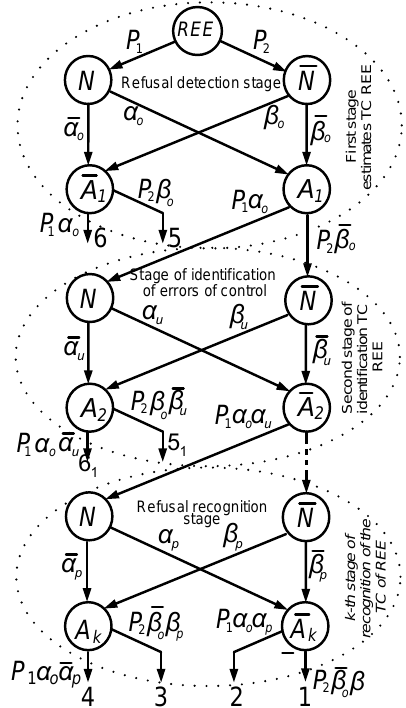
Fig. 1. The probabilistic approach for recognition of the technical condition of REE implementing the stage-by-stage principle of